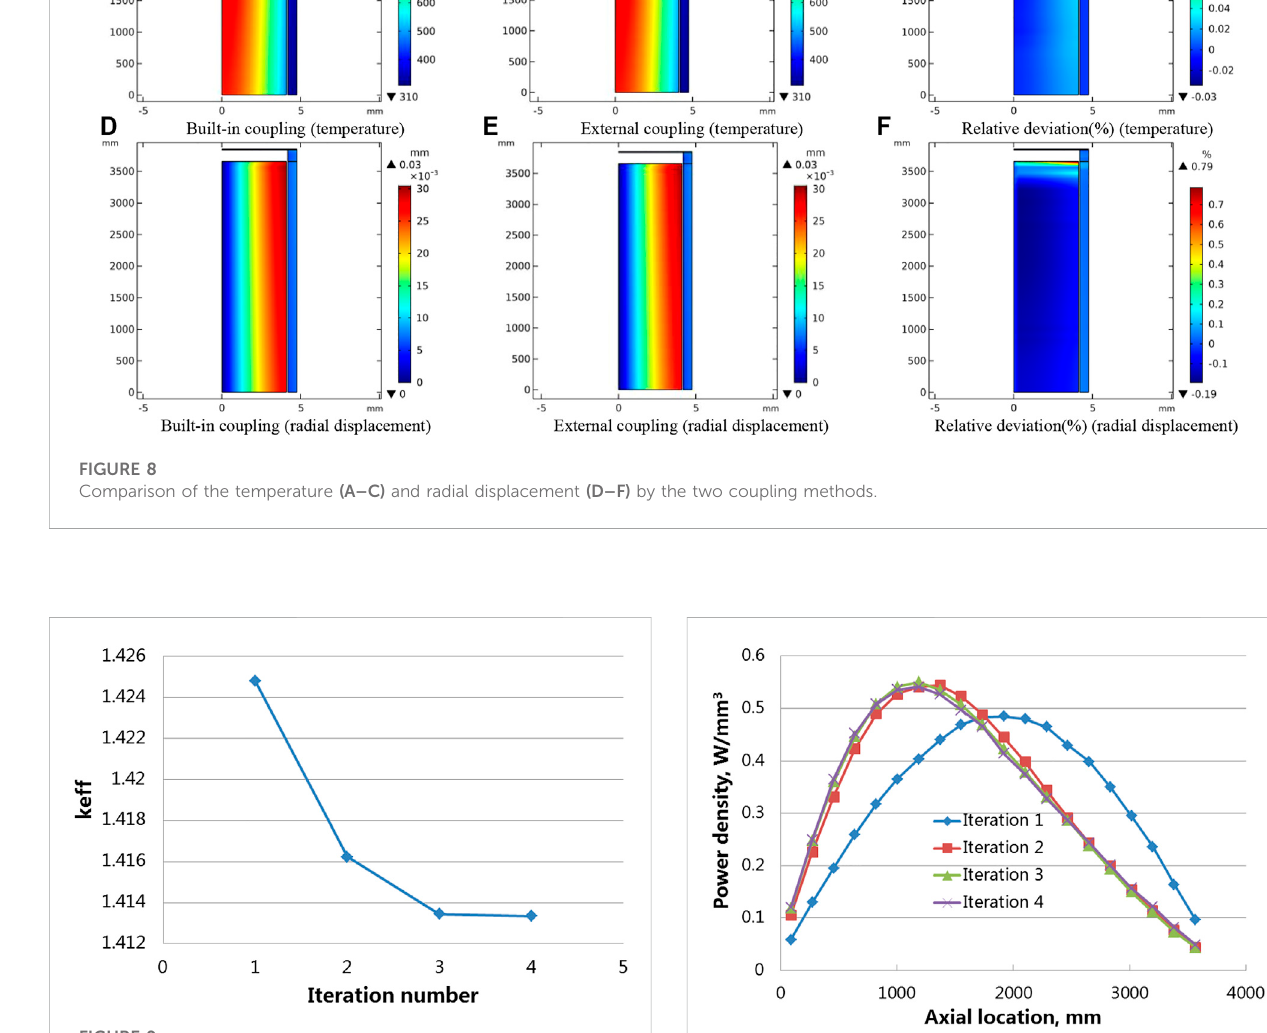
FIGURE 9 Variation of effective multiplication factor with Iteration